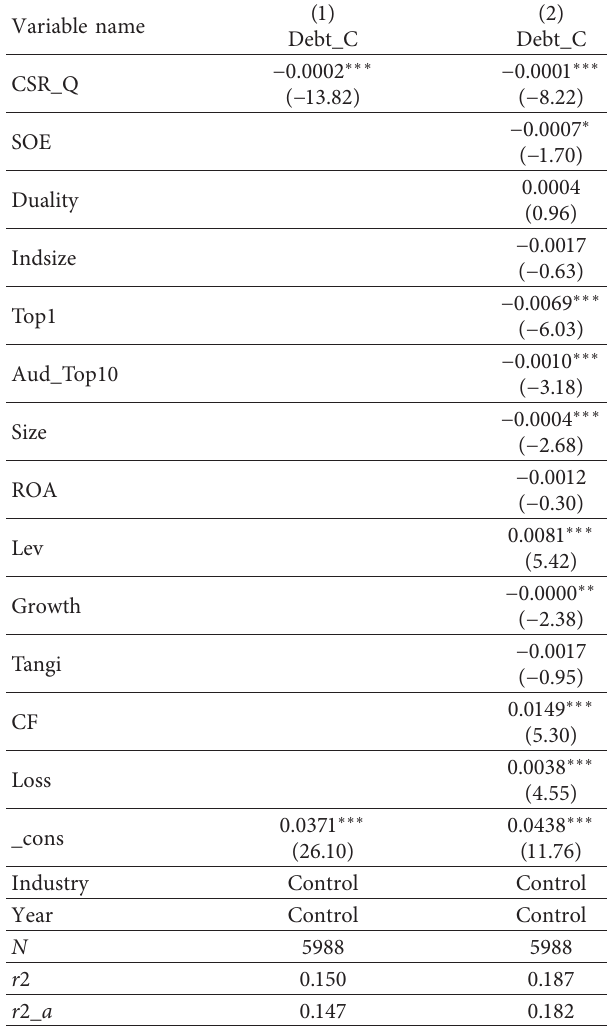
Table 4: Basic multiple linear regression